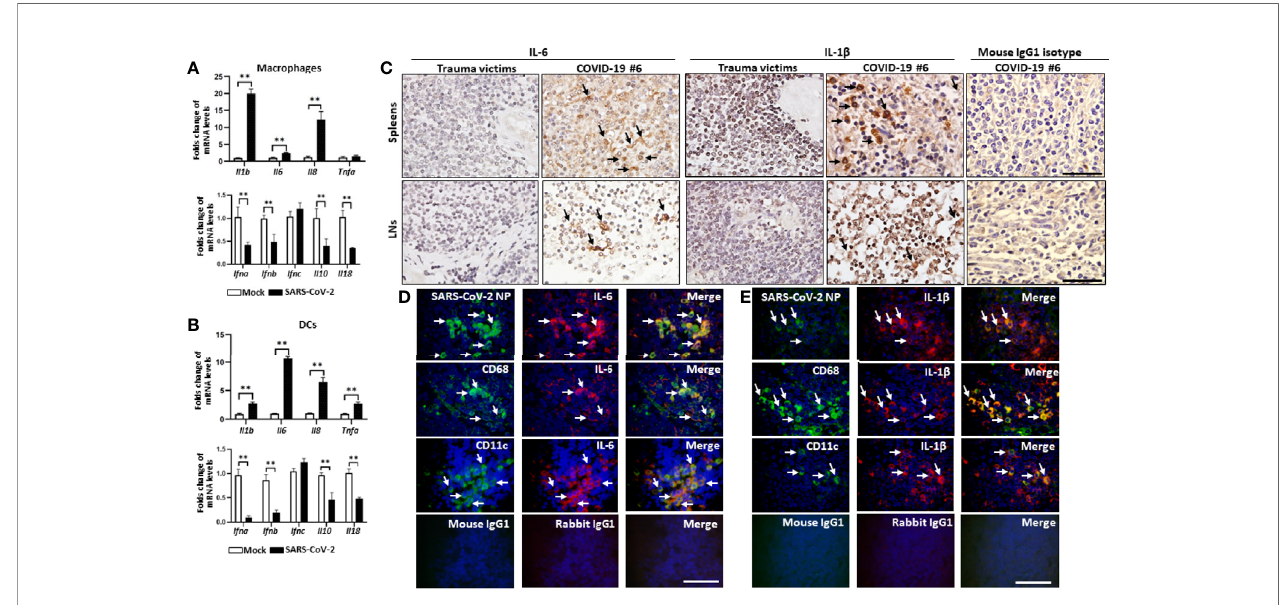
FIGURE 5 | SARS-CoV-2 triggers IL-1 b and IL-6 production by macrophages and DCs. Human MDMs and MoDCs were mock infected or infected with SARS- CoV-2 (MOI= 1.0) for 2h, after virus absorption, cells were washed and continuously cultured for 24h, the transcription of the indicated genes in (A) MDMs and (B) MoDC was detected by qRT-PCR, ** p < 0.01. The spleens and LNs from one representative COVID-19 patient post-mortem (case #5) and trauma victim were collected, (C) the expression of IL-6 and IL-1 b was analyzed by IHC, scale bar= 50 m M, arrows indicate positive cells; Sections from the hilar LNs were selected to analyze the secretion of (D) IL-6 and (E) IL-1 b from the indicated cells by immuno fl uorescent doublestaining. Scalebar=50 m M,arrows indicate doublepositive